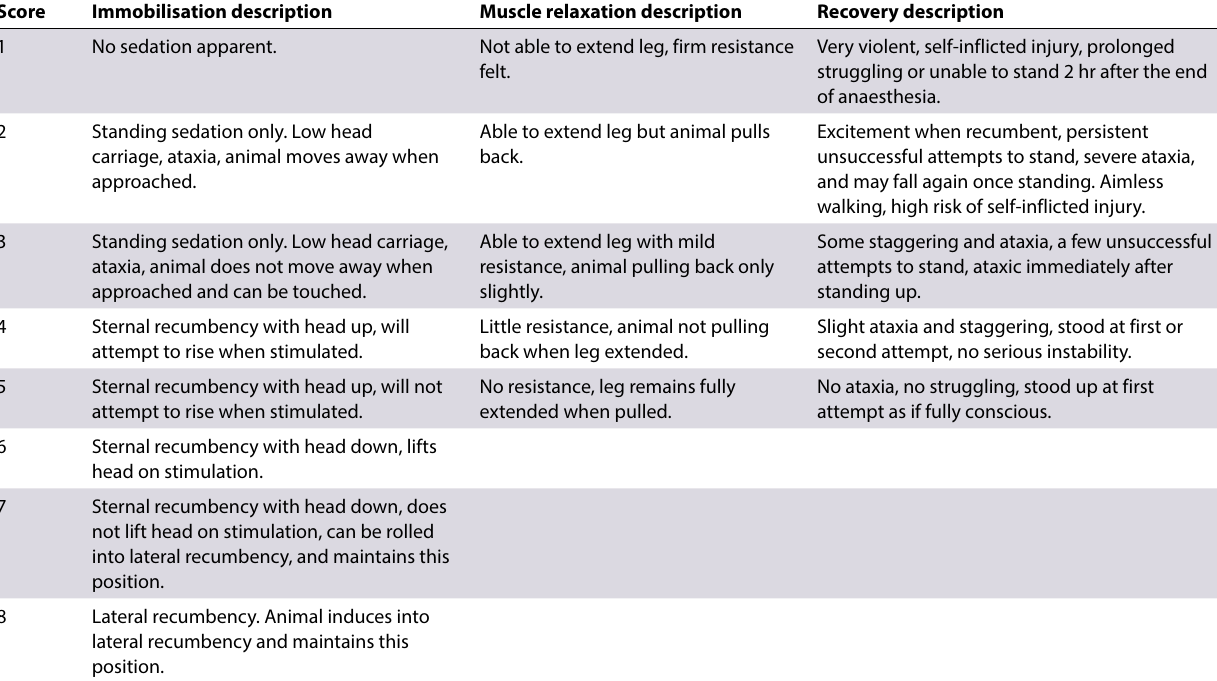
Table I: Immobilisation (recorded just after induction), muscle relaxation during recumbency and recovery quality scoring guidelines; recovery and induction scores are adapted from Pon et al. (2016) Score Immobilisation description Recovery